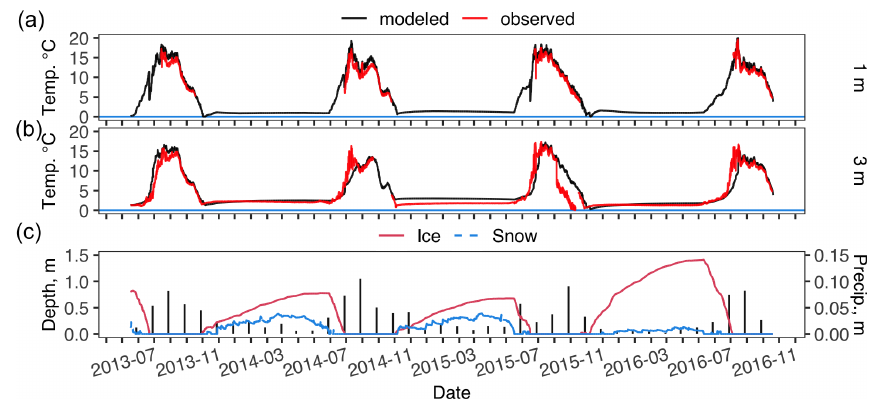
Figure B1. Modeled and observed lake water temperature at 1m (a) and 3m (b) and modeled lake ice depth, lake snow depth, and measured monthly precipitation (vertical black bars) (c) for Toolik Lake with no inflow. Missing observed data in (a) and (b) are due to seasonal placement and removal of the temperature sensors; see Sect. 2 for details.